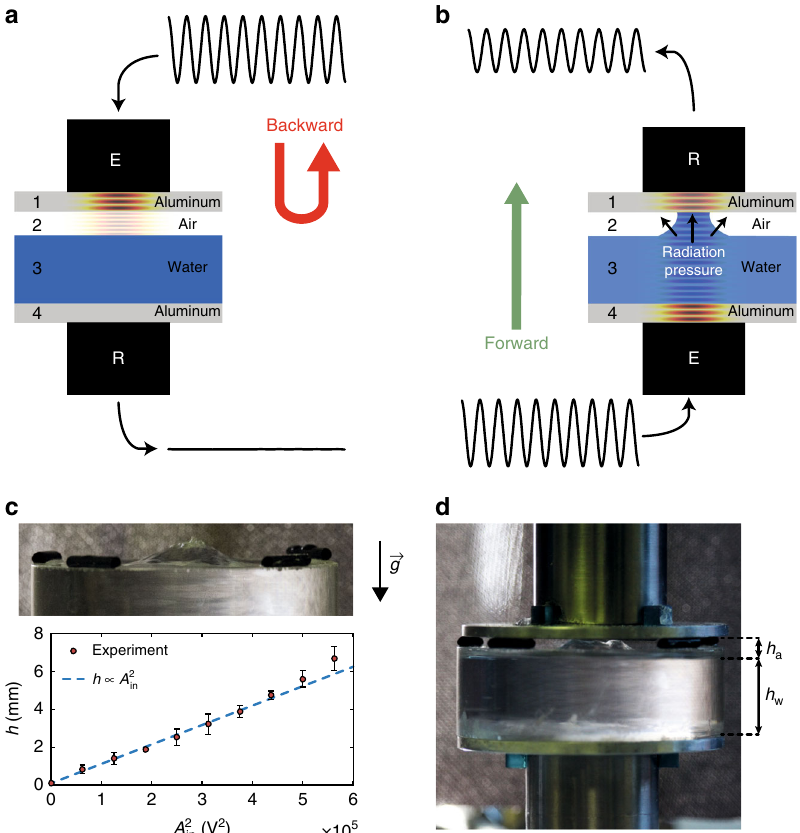
Fig. 1 Schematic principle of the concept and a picture of the prototype. a , b Schematic diagrams of the forward (emitter E at the bottom, receiver R at the top) and backward (emitter E at the top, receiver R at the bottom) transmission con fi gurations, respectively. c Radiation pressure effect on the water surface quasi-static deformation. Picture of the water bump, and experimental height as a function of the input electrical amplitude squared (error bars correspond to the standard deviation of 50 data points collected over 10s for each amplitude); d picture of the tested device when forward transmission is